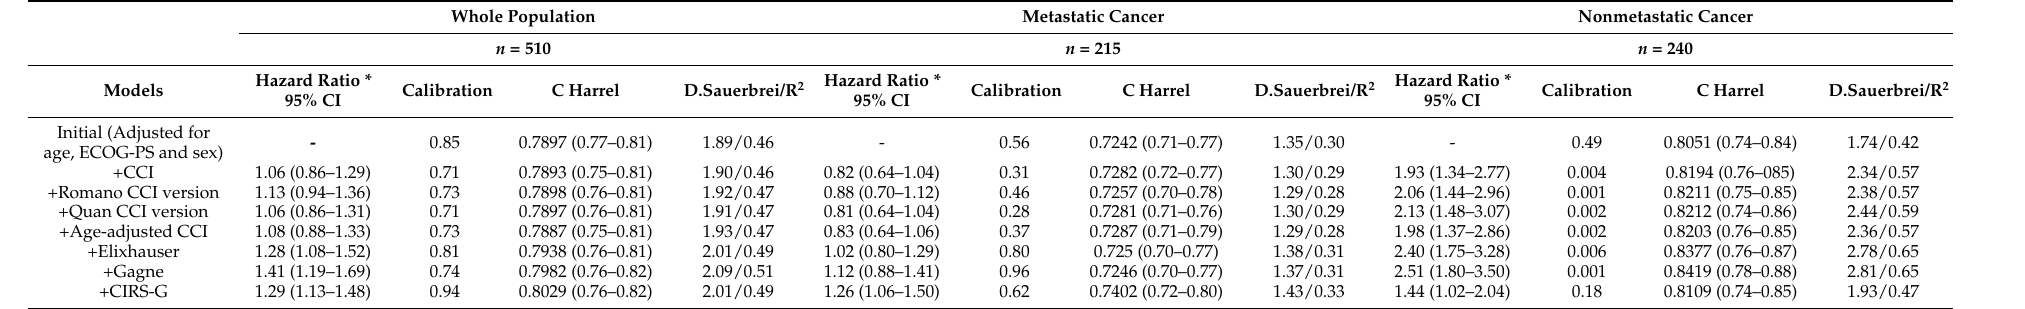
Table 2. The association of each comorbidity index with one-year mortality and the indices’ calibration and discriminant ability for the whole study population, metastatic and nonmetastatic cancer.